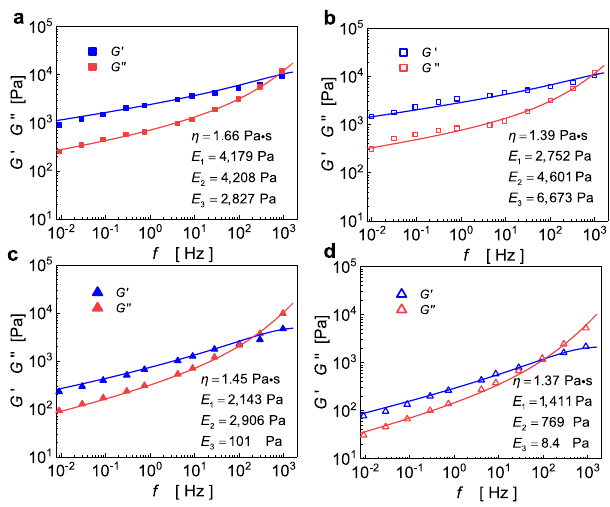
Fig. 4 The self-similar hierarchical model fi ts well with experimental data from ref. 8 on both storage and loss moduli under different drug treatments. a Untreated and treated with b histamine, c DBcAMP, and d cytochalasin